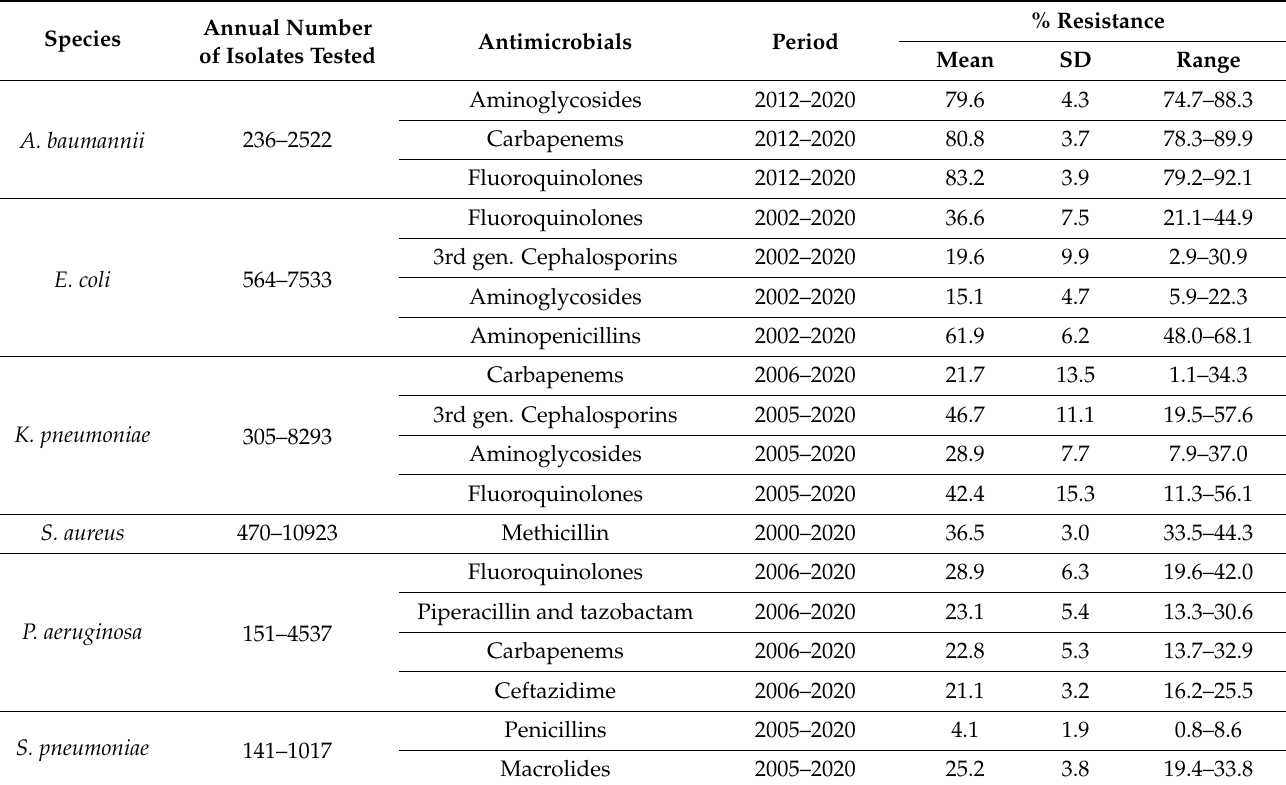
Table 1. Antimicrobial resistance in Italy for specific isolates and